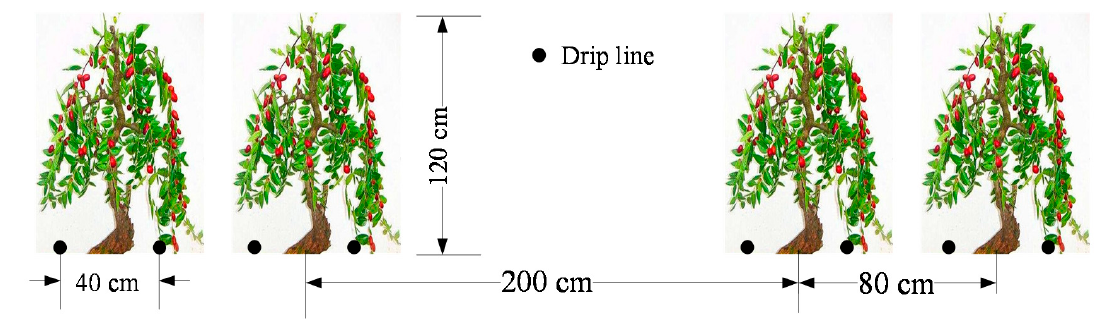
Figure 4. Planting patterns of jujube.